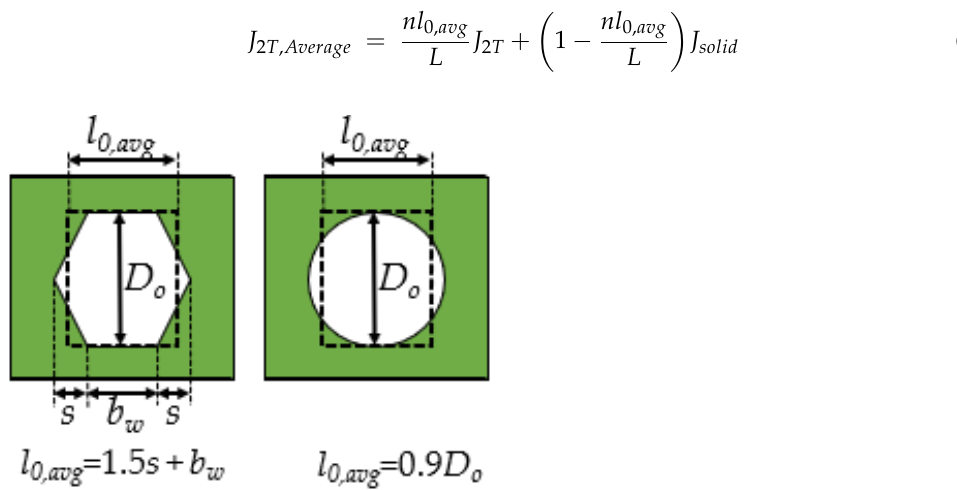
Figure 7. Equivalent rectangular openings for calculation of the adapted torsion constant. Adapted from Sonck and Belis [114,115].